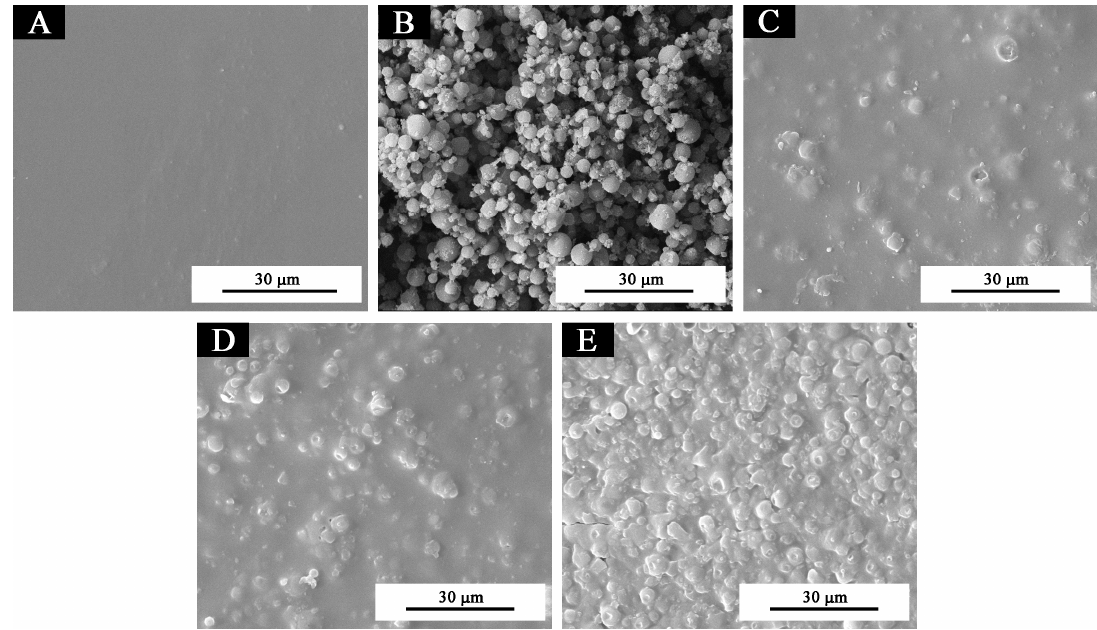
Figure 3. SEM of different concentrations of thermochromic pigment powder in the waterborne primer: ( A ) pure waterborne primer film; ( B ) thermochromic pigment powder; ( C – E ) 5%, 10% and 30% thermochromic pigment powder in the waterborne primer, respectively.